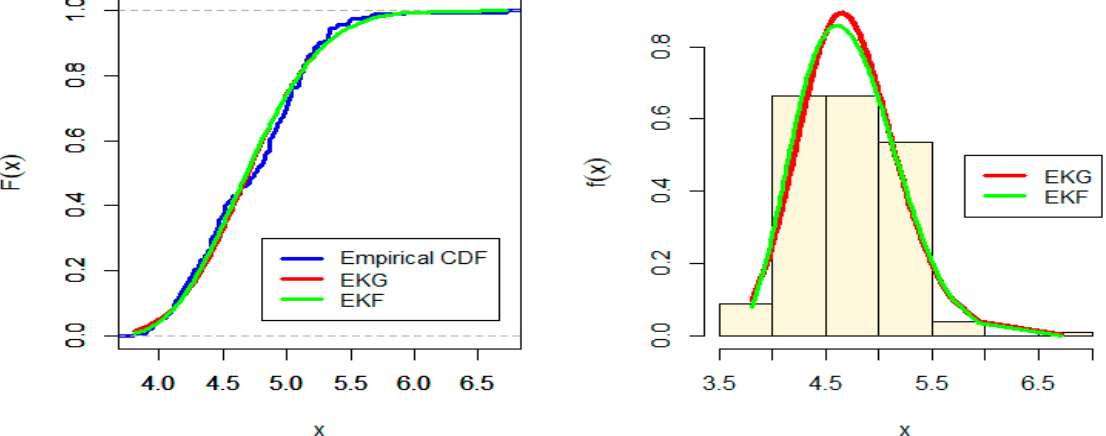
Figure 8. Estimated CDF and PDF for EKG and EKF distribution for Australian Athletes data.